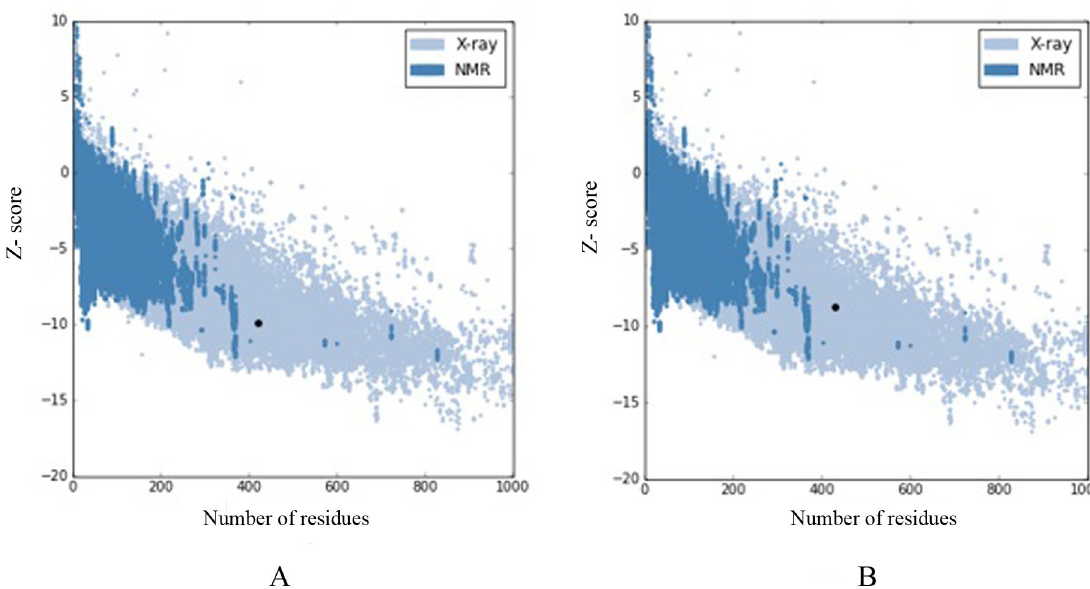
Fig 5. Z-score values for (A) the template, (B) the simulated model (MO323). Both structural models are located in the position of X-ray structures.